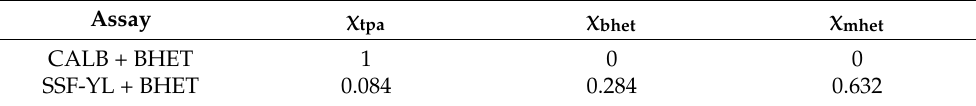
Table 1. Molar fractions after 168 h of reaction using BHET and PC-PET as hydrolysis substrates at 37 °C and 180 rpm.